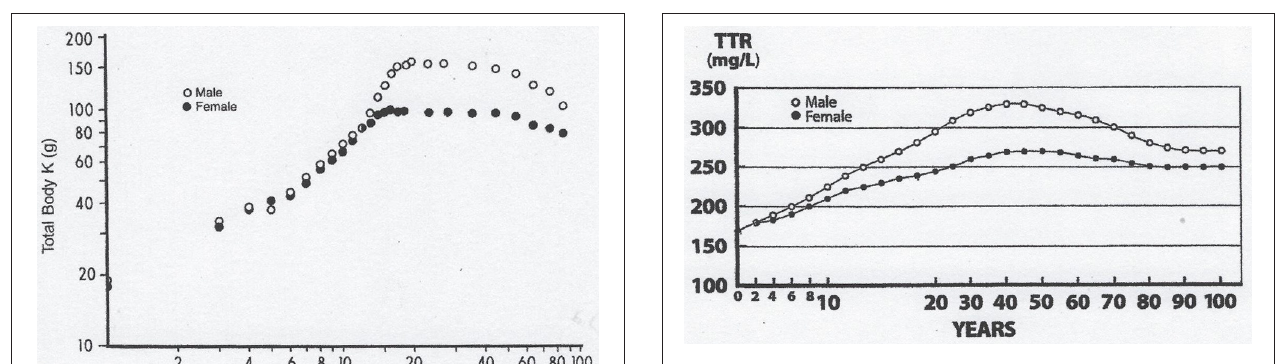
FIGURE 2 | Evolutionary patterns of TTR concentrations throughout the human lifespan. TTR concentration are measured in the blood samples on 67,720 healthy US citizens using immunoturbidimetric analysis (19). TTR and LBM values manifest closely superimposable trajectories: Lowest values measured at birth, linear progression without sexual difference until the onset of puberty, occurrence of sexual dimorphism with more pronounced rise in adult males because of a large musculature, followed by plateau levels until the age of 60y, and finally gradual downsizing toward sacropenia in both sexes with a steeper slope observed in elderly males. Both TTR and LBM curves show comparable abrupt S-shape elevations from the onset of adolescence until the beginning of adulthood, which are here partially obliterated due to changes in the graduation of the abscissa